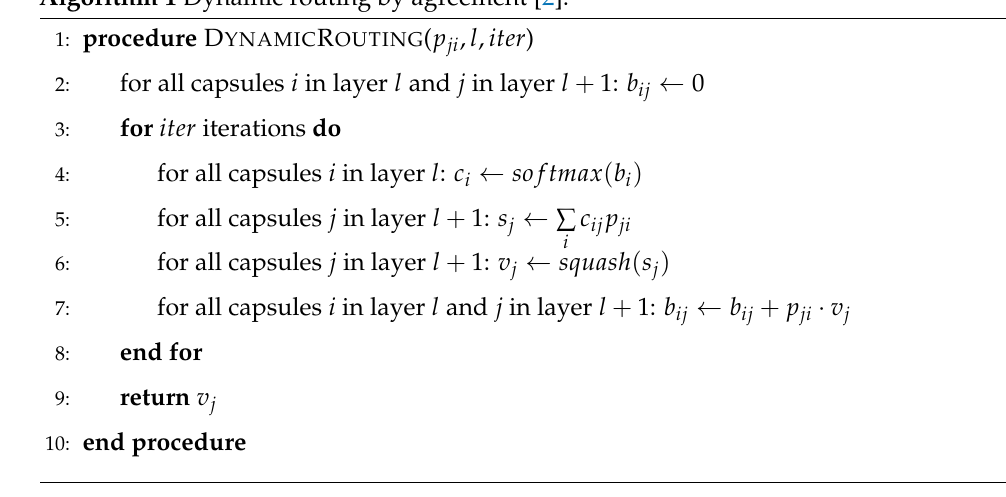
Algorithm 1 Dynamic routing by agreement